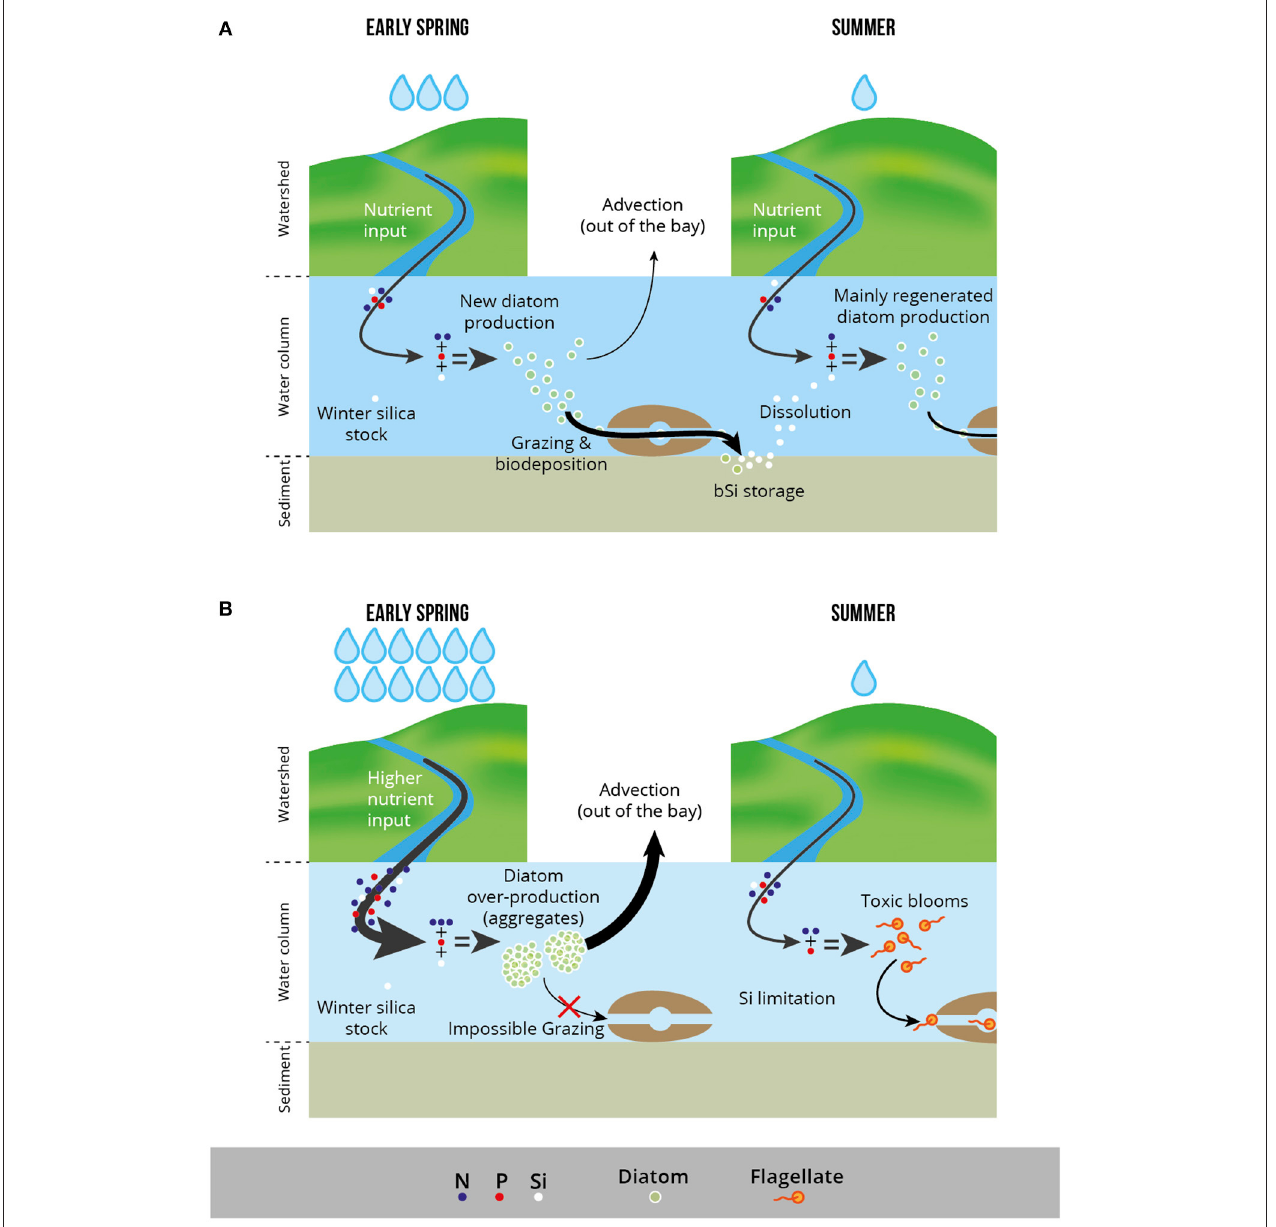
FIGURE 2 | The Crepidula/Si working hypothesis (redrawn from Chauvaud et al., 2000). Two contrasting situations are displayed. On top (A) , under “normal” climatic conditions, the diatom spring production is being grazed by benthic suspension feeders, dominated by Crepidula ; the Si is being stored in the sediment and slowly released as silicic acid during summer, allowing the maintenance of diatoms in the system. At the bottom (B) , the spring diatom production cannot be grazed and most of the diatom production is exported out of the Bay, depleting the system in silicic acid and favoring a summer production of dinoflagellates. In this figure, reasons for the impossible grazing are linked to excessive nutrient inputs under heavy rains, and the formation of diatom aggregates, that sediment massively to the bottom and cannot be as easily grazed. Other situations may lead to the prevention of such grazing and biodeposition activities. See text for more